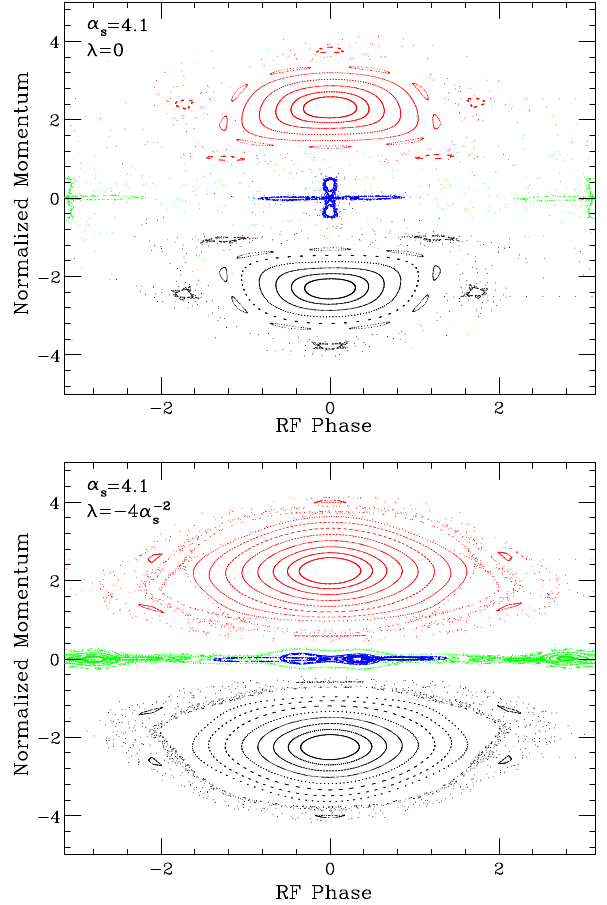
FIG. 3. Top: phase-space structure with slip-stacking parameter α ¼ 4 . 1 without second-harmonic rf compensation, i.e. λ ¼ 0 . s Bottom: phase-space structure when the second-harmonic rf compensation is turned on, or λ ¼ − 4 = α 2 s ¼ − 0 . 238 . The inter- action of two primary buckets is so strong that the phase space between them becomes chaotic. Only the cores of the fifth-order resonance islands are stable in the top plot. Once the compensa- tion rf is included, the chaotic region becomes smaller. There are stable tori outside the fifth-order resonance islands and the stable bucket area increases, i.e., a larger injection bunch area can be accepted.